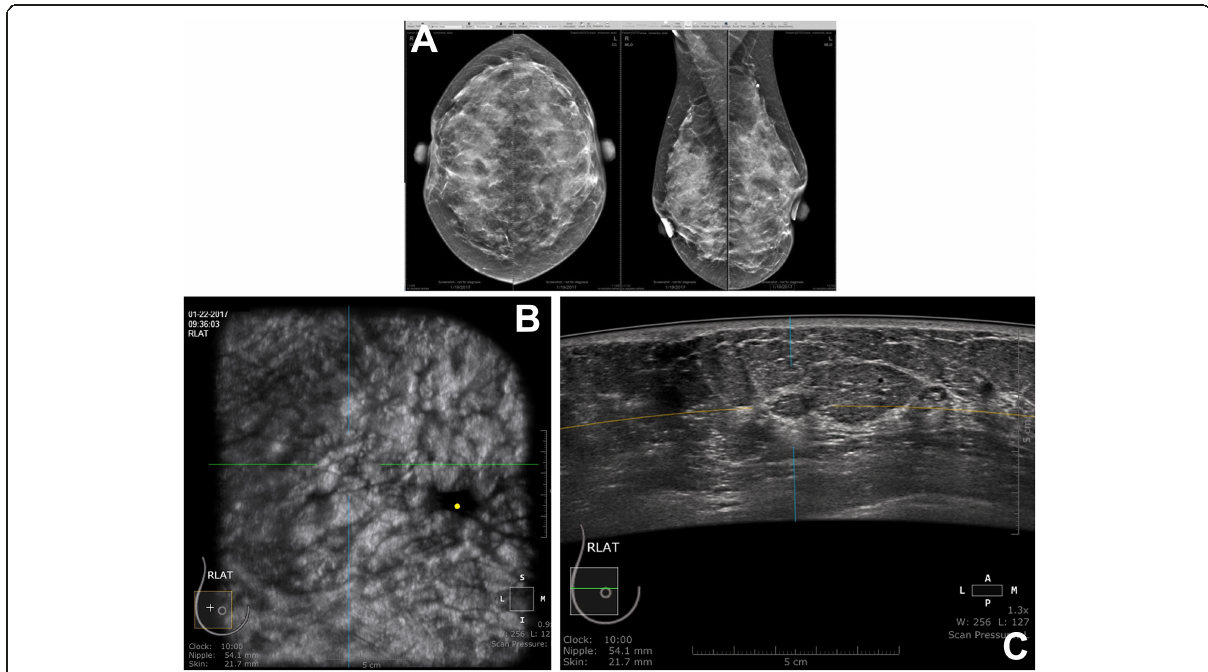
Fig. 3 Female patient 31 years old with histopathological diagnosis of fibroadenoma. a Mammogram (cranio-caudal and mediolateral oblique views of both breasts) showing dense breast (ACR D) with no obvious lesions or calcifications. b Coronal reformatted ABUS image showing a small hypoechoic lesion in the upper outer quadrant of the right breast. c Axial reformatted ABUS image showing the small well-defined hypoechoic lesion